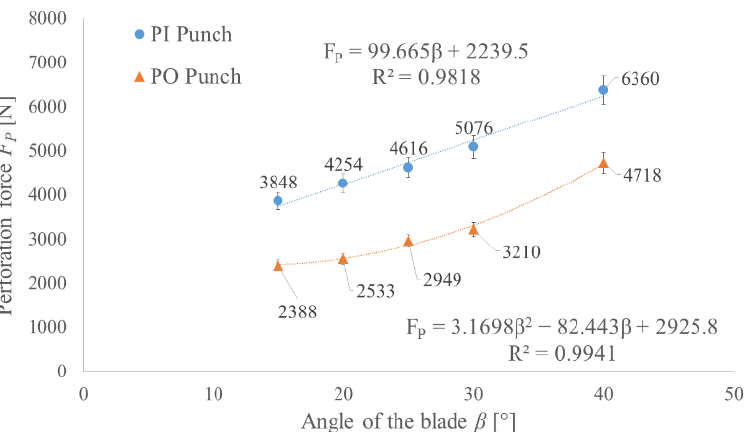
Figure 18. The influence of the angle of the blade β on the perforation force F P for both PI and PO punches with diameter d = 10 mm and height of the blade H = 2.65 mm for belt TFL10S. In order to gain the lowest possible perforation force (minimum force criterion), the angle of the blade should be minimized, but it will cause a small thickness of the wall of the hollow punch if we assume the constant height of the blade. In order to take into consider- ation the durability of the punch (minimum stress criterion), the compressive stress in the punch was determined as the peak perforation force divided by the punch cross section. To determine the compressed section of the punch, the depth of the penetration x in Equation (1)